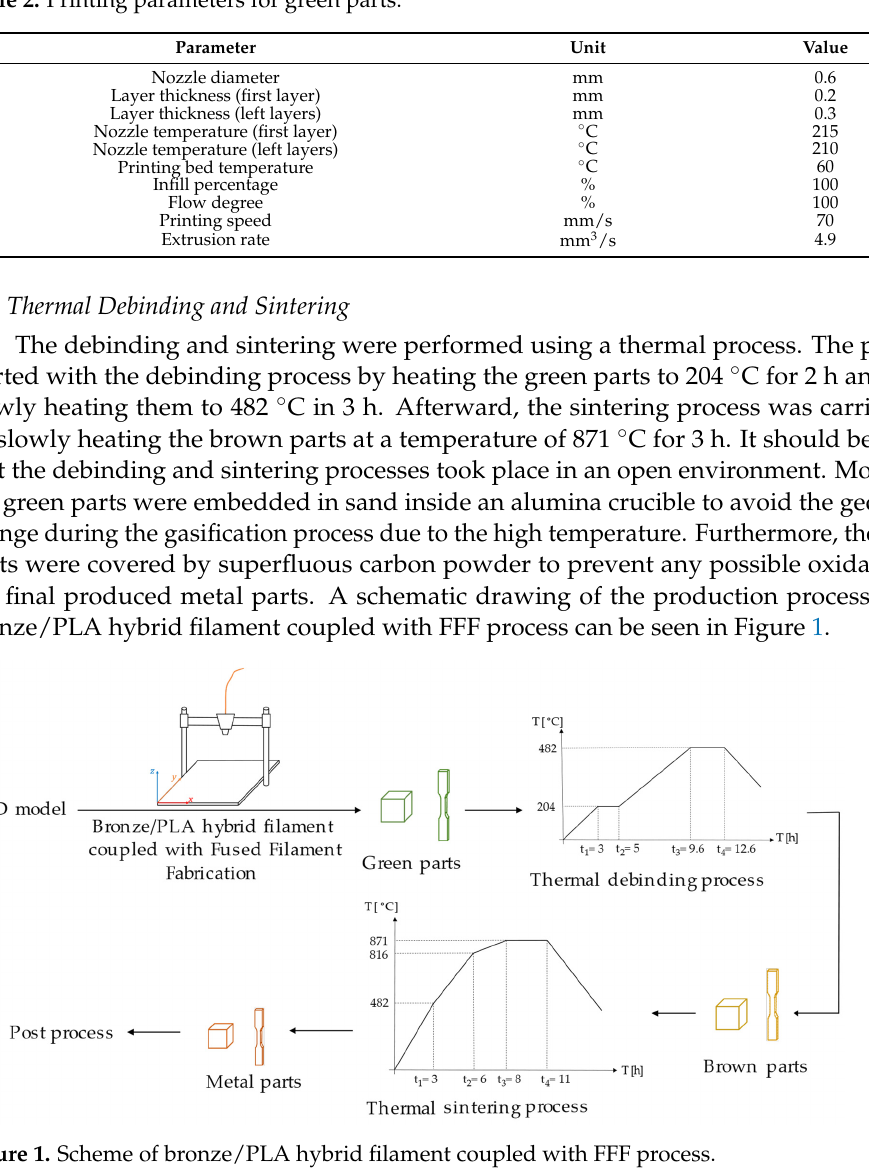
Table 2. Printing parameters for green parts.